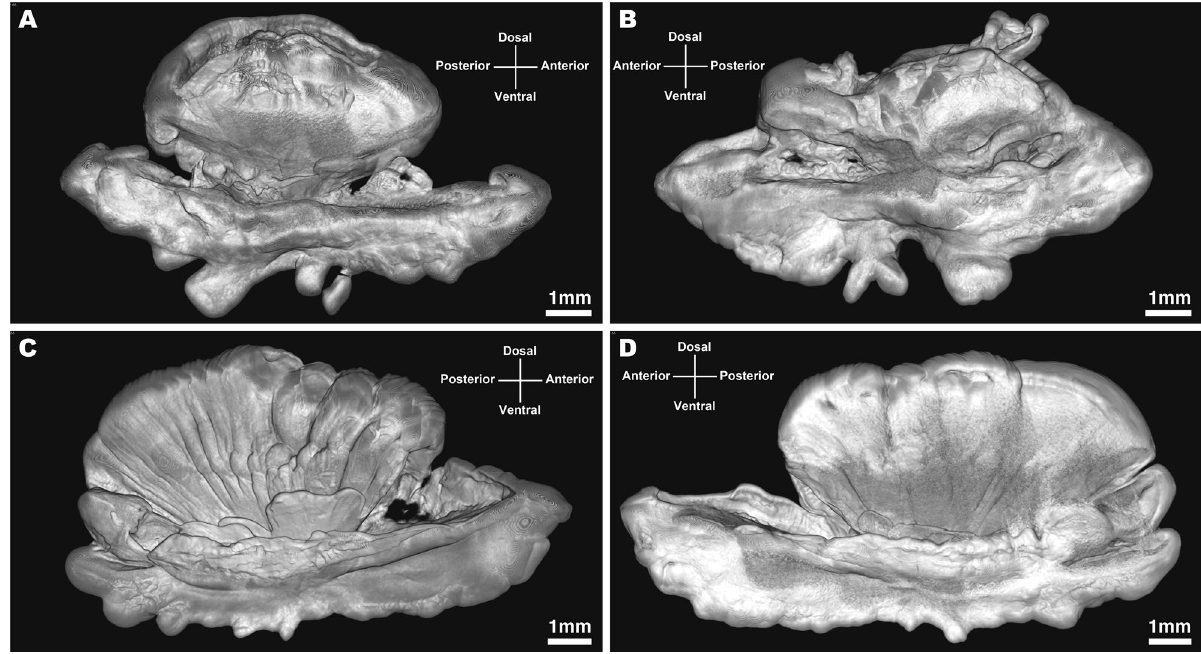
Figure 3. Narcetes shonanmaruae . Micro-computed tomography images of otoliths. ( a ) and ( b ) Holotype (SH8- 69). ( c ) and ( d ) Paratype 1 (SH8-43). ( a ) and ( c ) Medial view of left otolith. ( b ) and ( d ) Medial view of right otolith. Scale bar: 1